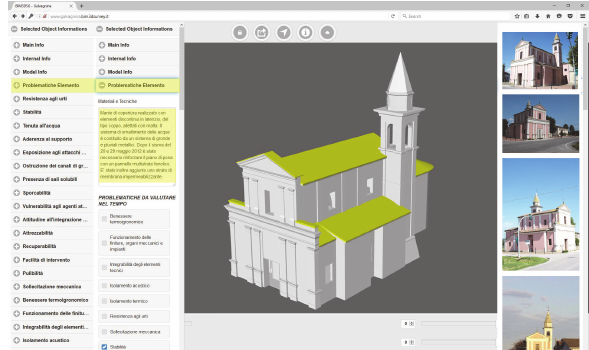
Figure 3. BIM3DSG dynamic information for the web. Groups and fields are created dynamically, reading them from the database, so that their changes are retrieved almost in real time.